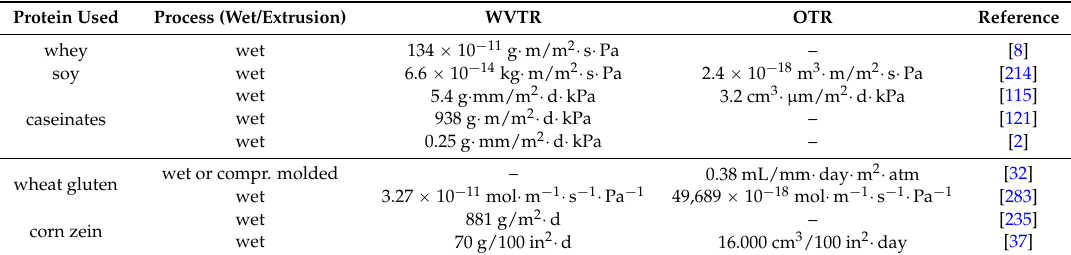
Table 5. Reported barrier performances for coatings applied on paper based on the commonly used proteins (best value reported when several samples were tested).